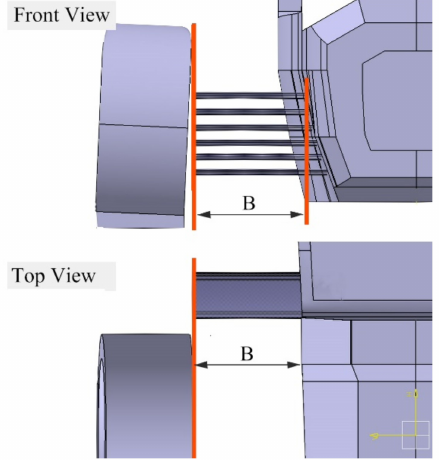
Figure 16. Shutters’ width B is constrained by the inner side of vertical plane